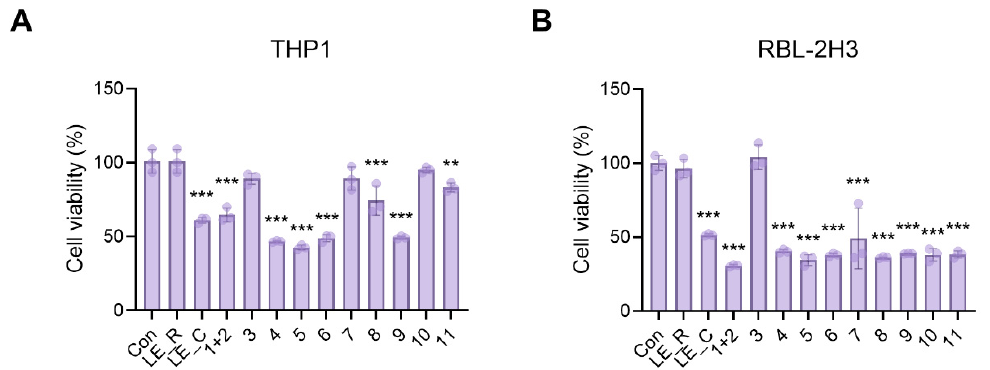
Figure 6. Cytotoxic effects of compounds isolated from the L. erythrorhizon cold and reflux EtOH extracts against THP1 and RBL-2H3 cells. ( A , B ) Viability of ( A ) THP1 and ( B ) RBL-2H3 cells, as assessed in an MTT assay after 24 h exposure to the indicated extracts (50 µ g/mL) or isolated compounds (50 µ M). LE_R, 95% ethanol reflux extraction at 70 ◦ C; LE_C, 95% ethanol extraction at room temperature: (1) erythrin A, (2) erythrin B, (3) N,N ′ -dicoumaroylspermidine, (4) anhydroalkannin, isovalerylshikonin. Data are expressed as the mean ± SD. ** p < 0.01 and *** p < 0.001 versus the control group. Experiments were independently repeated three times. 2.5. Assessment of NF-kB, AP1, and IRF Activation The NF- κ B, AP1, and IRF transcription factor families play important roles in inflammatory responses by promoting the transcription of a variety of cytokines, including TNF α , IL-6, and IFN- α / β [27]. In addition, toll-like receptors (TLRs) activate a common signaling pathway that results in the induction of inflammatory cytokines such as TNF α and IL-6 via the activation of NF- κ B, AP1, and IRF. To determine whether N,N ′ - dicoumaroylspermidine regulates NF- κ B, AP1, or IRF activity, we used THP1-XBlue (for NF- κ B/AP1 activity) and THP1-ISG-Blue (for IRF activity) reporter cells stimulated with TLR2 or TLR4. These cells release inducible reporter proteins upon the activation of the NF- κ B/AP1 and IRF (secreted embryonic alkaline phosphatase) pathways. First, the cells were pretreated for 1 h with or without N,N ′ -dicoumaroylspermidine and then stimulated for 24 h with a TLR2 ligand (Pam3CSK4 or zymosan) or a TLR4 ligand (lipopolysaccharide (LPS)). Pam3CSK4, zymosan, and LPS all significantly increased NF- κ B/AP1 and IRF activity. However, N,N ′ -dicoumaroylspermidine had no effect on NF- κ B/AP1 and IRF activity when treated in addition (Figure 7A,B). Figure 7. N,N ′ -dicoumaroylspermidine has no effect on activation of NF-kB, AP-1, and IRF. ( A ) NF- kB, AP-1, and ( B ) IRF reporter cells (THP1-Xblue and THP1-Blue-ISG cells, respectively) were